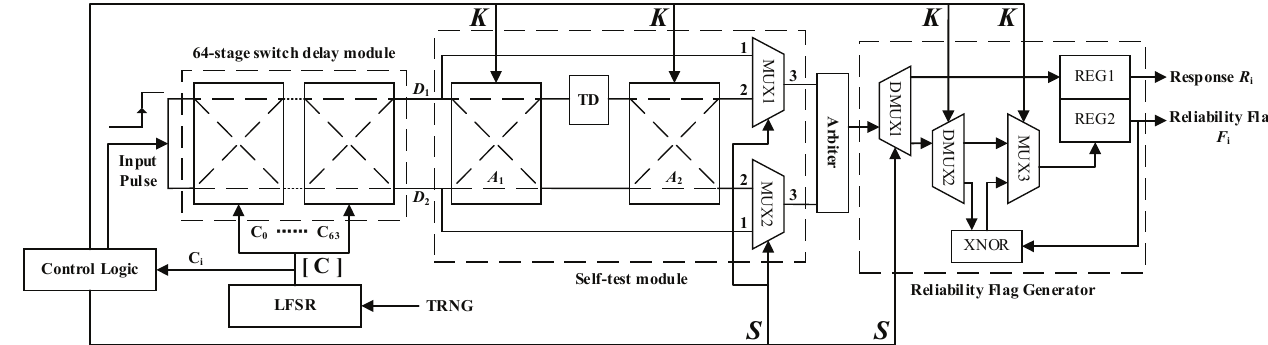
Figure 6. Structure of the BST Arbiter PUF.